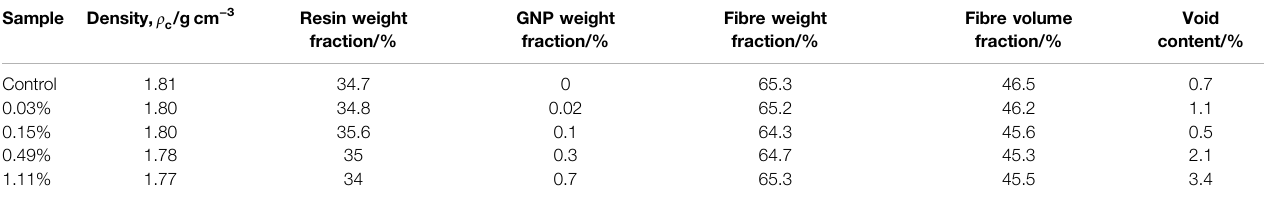
TABLE 3 | Density, fi ber weight/volume fraction, and void content of composites with different GNP loadings. Sample Density, ρ c /gcm − 3